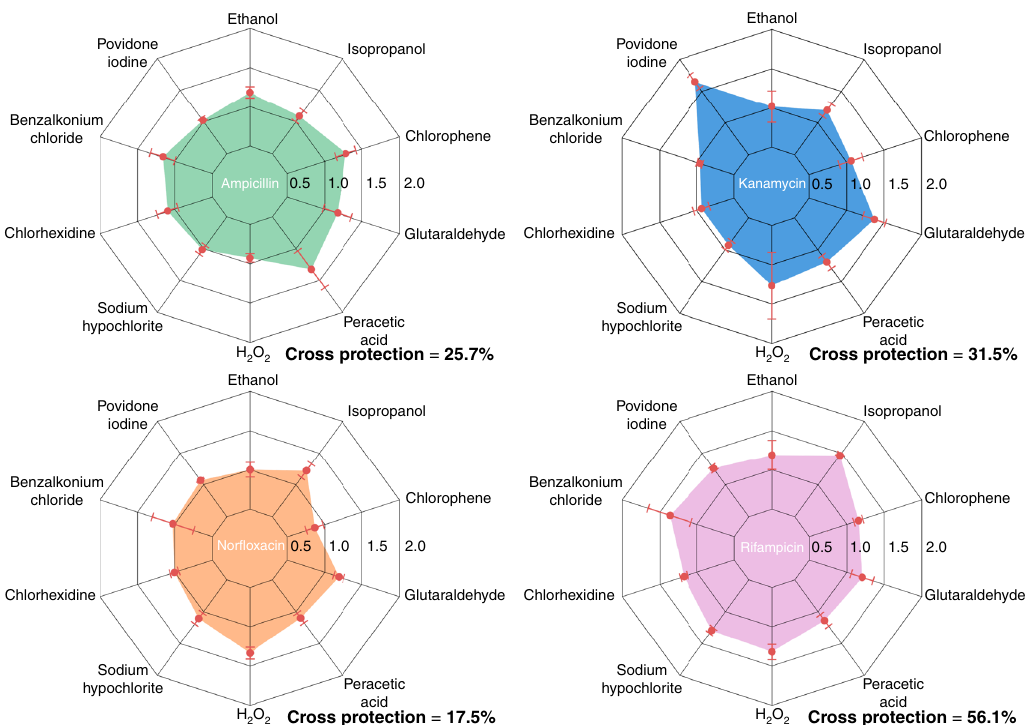
Fig. 4 Cross-stress behavior plots of E. coli exposed to biocide, followed by an antibiotic. The cross-protection percentage for each antibiotic represents the relative difference of the shaded area compared to that of the decagon with no cross-stress behavior. A cross-stress protection index (CSPI) of more than 1 denotes cross-protection of biocide-treated cells in antibiotic compared to biocide-untreated cells. CSPI less than 1 indicates cross-vulnerability of biocide-treated cells in antibiotic compared to the biocide-untreated cells. The error bars represent the standard error of mean among 3 – 4 biological replicates centered at their